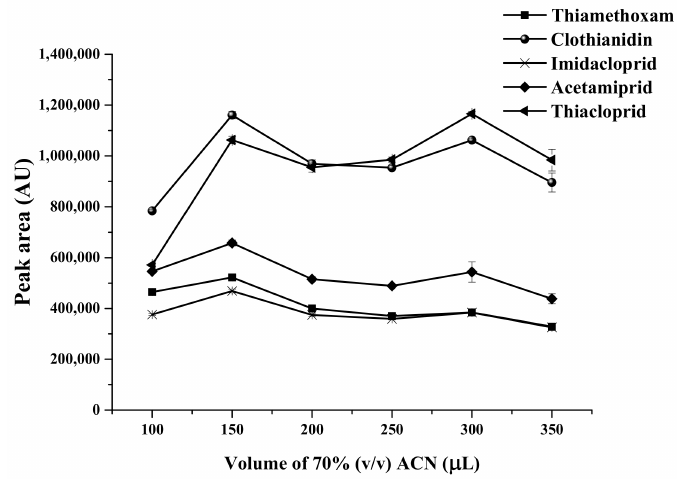
Figure 5. Effect of volume of 70% acetonitrile on extraction efficiency using 30 mg MMT sorbent, sample volume of 13 mL, and 0.03 g Na 2 SO 4